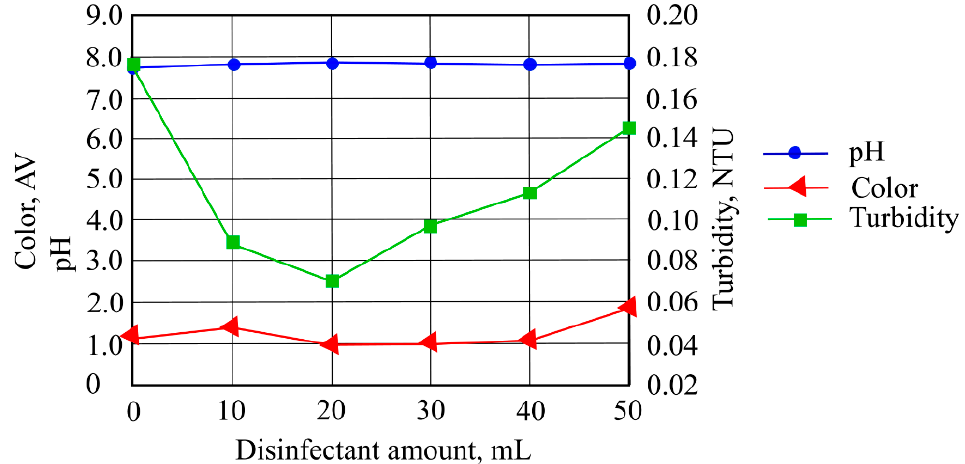
Figure 8. The impact of disinfectants on stormwater pollution indicators after contact with waste materials.